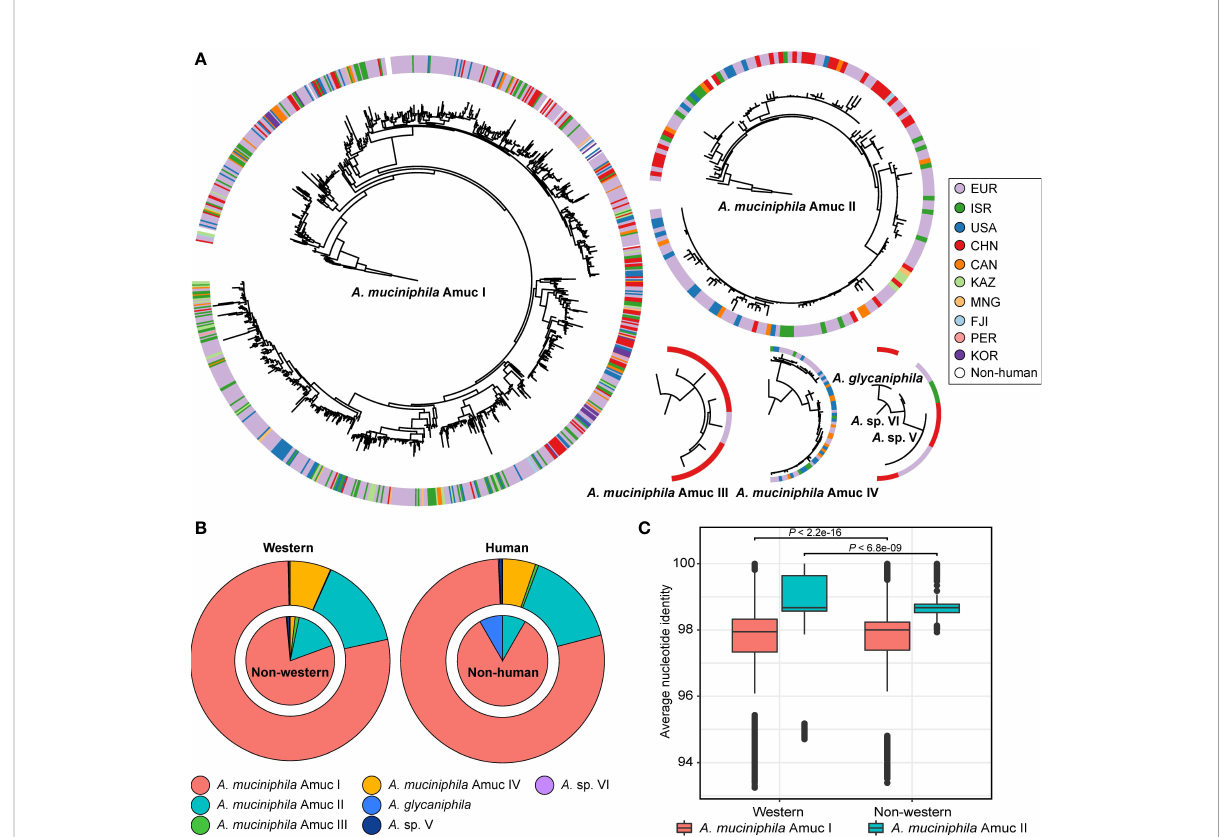
FIGURE 4 Geographic and host source of seven Akkermansia species and phylogroups. (A) Phylogenetic characteristics of Akkermansia species and phylogroups, with circles representing the national origin of each strain. (B) The distribution of Akkermansia species and phylogroups in Western and non-Western populations (left panel) and human and non-human hosts (right panel). (C) Boxplot shows the intra-phylogroup ANI comparisons between Western and non-Western